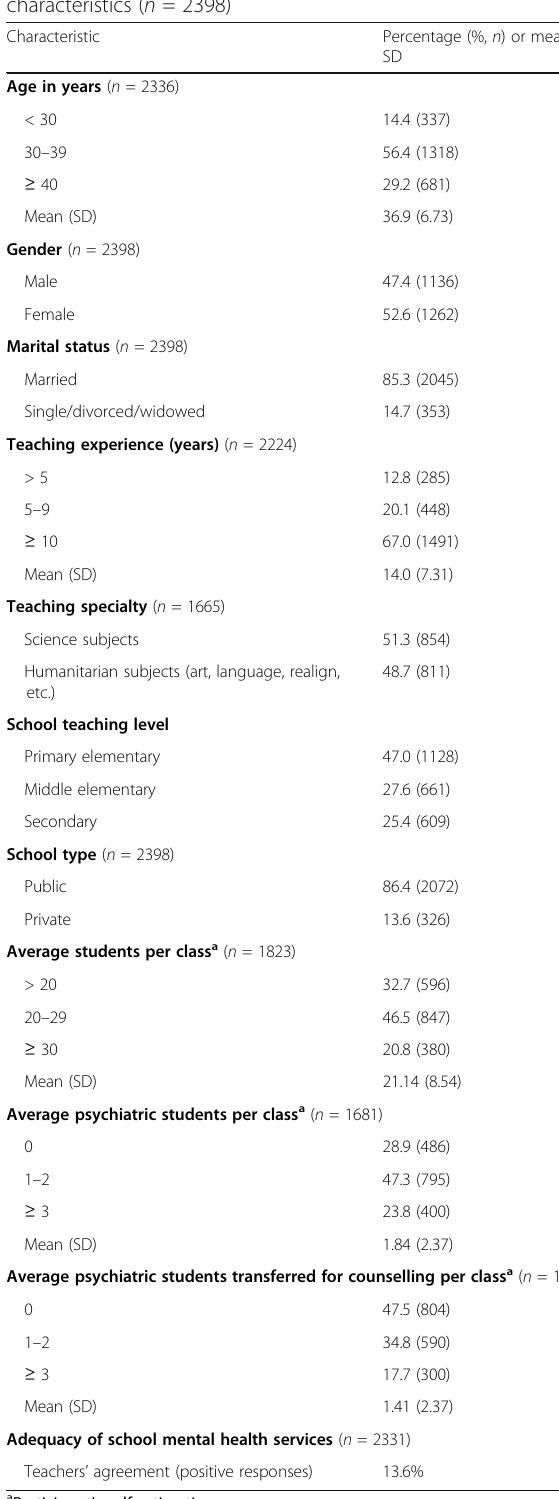
Table 1 Teachers ’ background information and